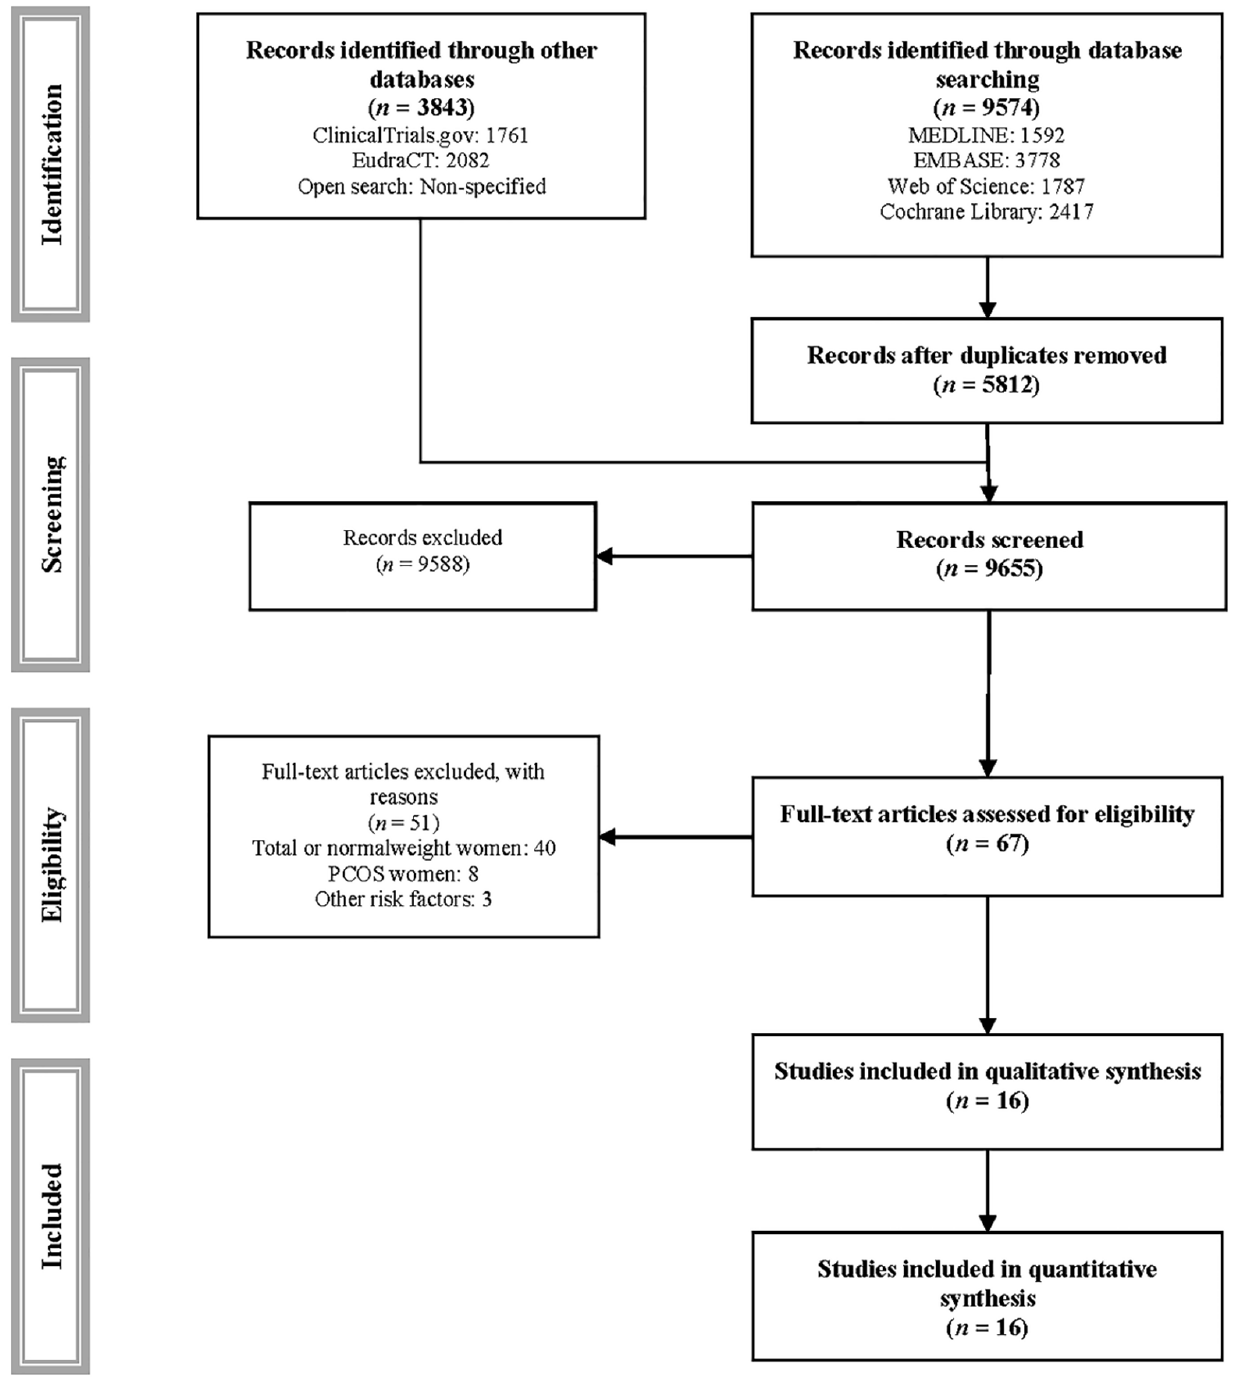
Figure 1. PRISMA flowchart of study selection.